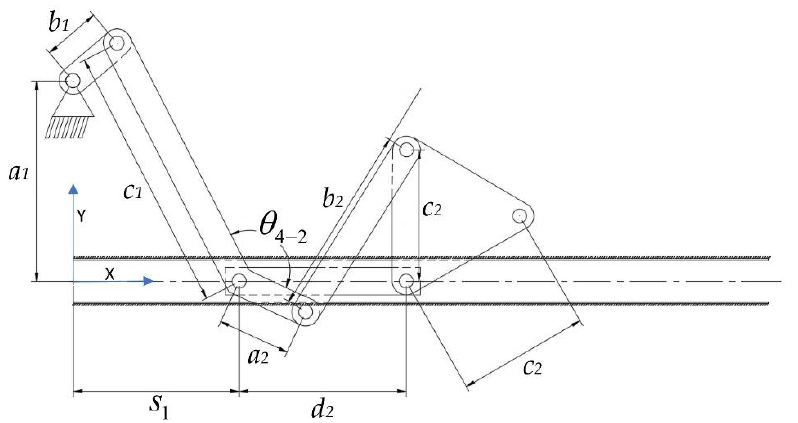
Figure 9. The combined structure of the pharyngeal jaw.